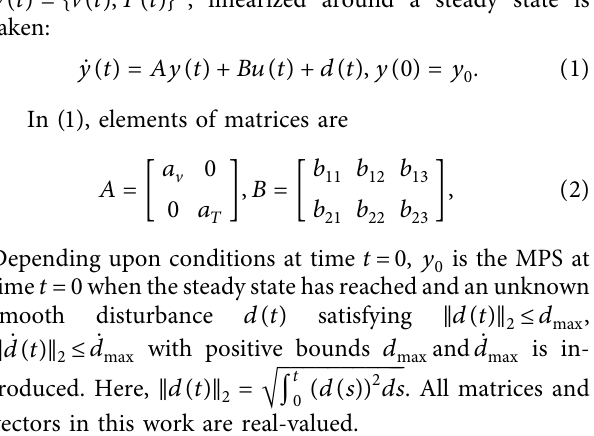
Figure 2: Block diagrams of three MR-MRACs used in an APSP for producing FGCs. Te MPSs ( v ( t ) , T t ( )) of powder particles in the observation window are input to MR-MRAC-1 that adjusts fow rates of the argon and the hydrogen and the current, ( P ( t ) , Q ( t ) , I t ( ))( . Te averaged z – location, C ( j ) z ( t ) , of powder particles measured in the observation window is an input to the MR-MRAC-(j+1) that adjusts the average injection velocity V ( j ) inj and the y – location d ( j ) y of the injector ( j � 1 for NiCrAlY and j � 2 for ZrO 2 particles).